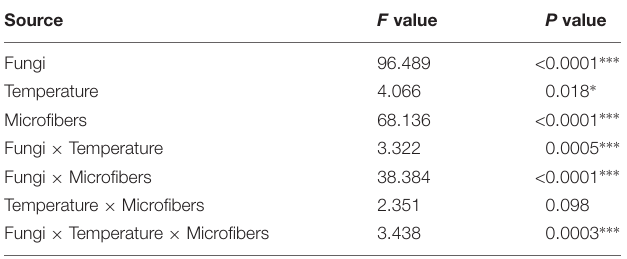
TABLE 1 | ANOVA results for the effects of fungi, temperature, plastic microfibers and the interaction of these factors on percentage of water-stable macroaggregates.